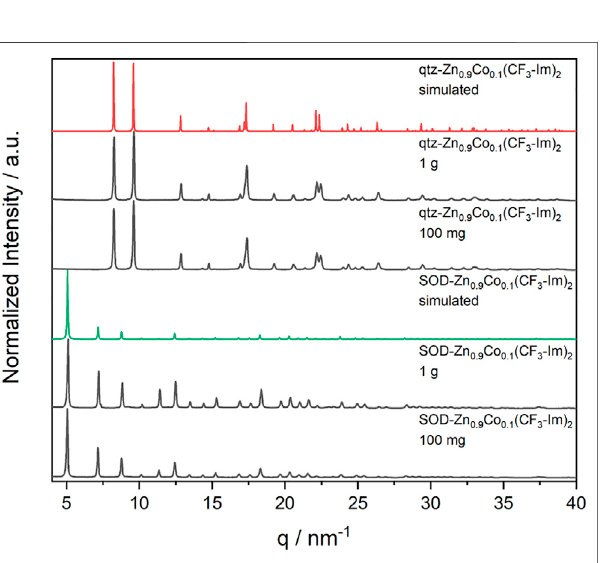
FIGURE 5 | XRD data of as-synthesized powders of Zn 0.9 Co 0.1 (CF 3 - Im) 2 , in 100-mg and 1-g scale (all black) prepared by Scheme 5, with the respective goal structures SOD-Zn 0.9 Co 0.1 (CF 3 -Im) 2 (green) and qtz- Zn 0.9 Co 0.1 (CF 3 -Im) 2